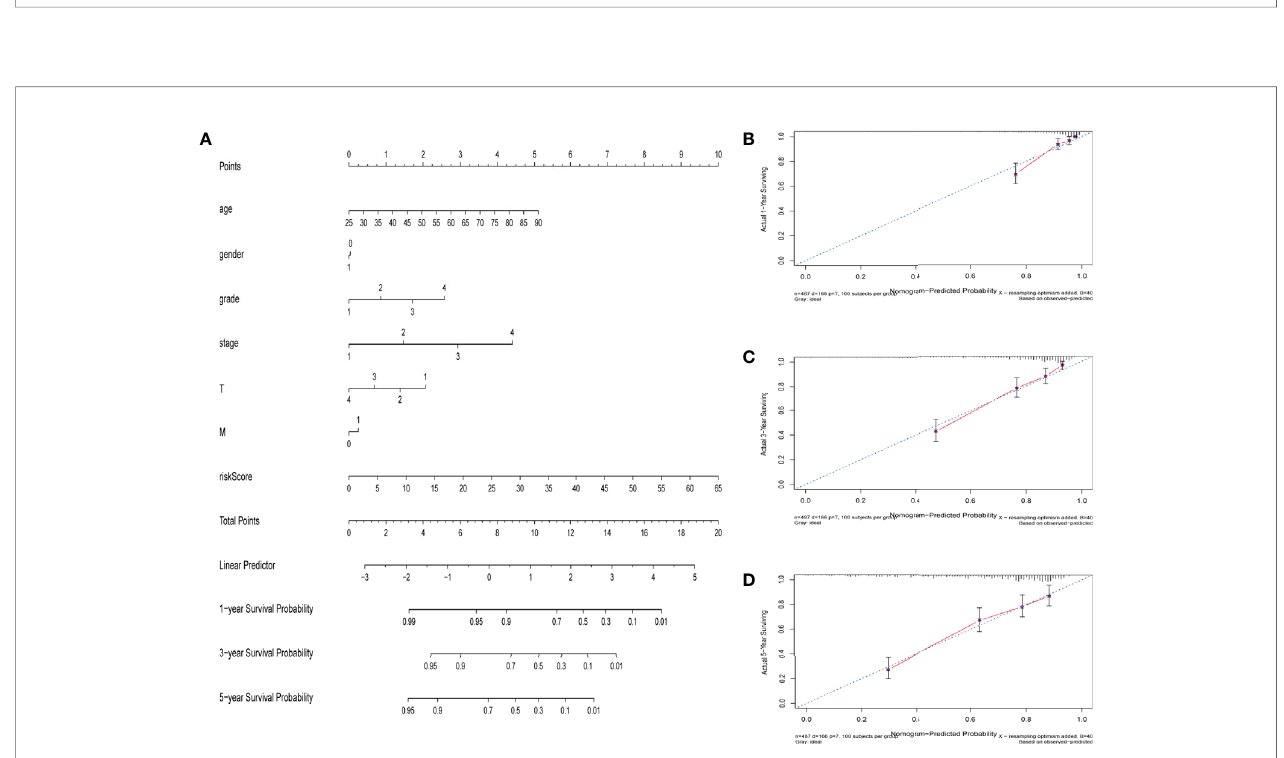
FIGURE 4 | Construction and veri fi cation of nomogram. (A) The prognostic nomogram constructed based on the risk score of ferroptosis-related genes and clinicopathological parameters predicted the survival rate of ccRCC patients at 1, 3, and 5 years. (B – D) Calibration curves showed the concordance between predicted and observed 1, 3 and 5-years survival